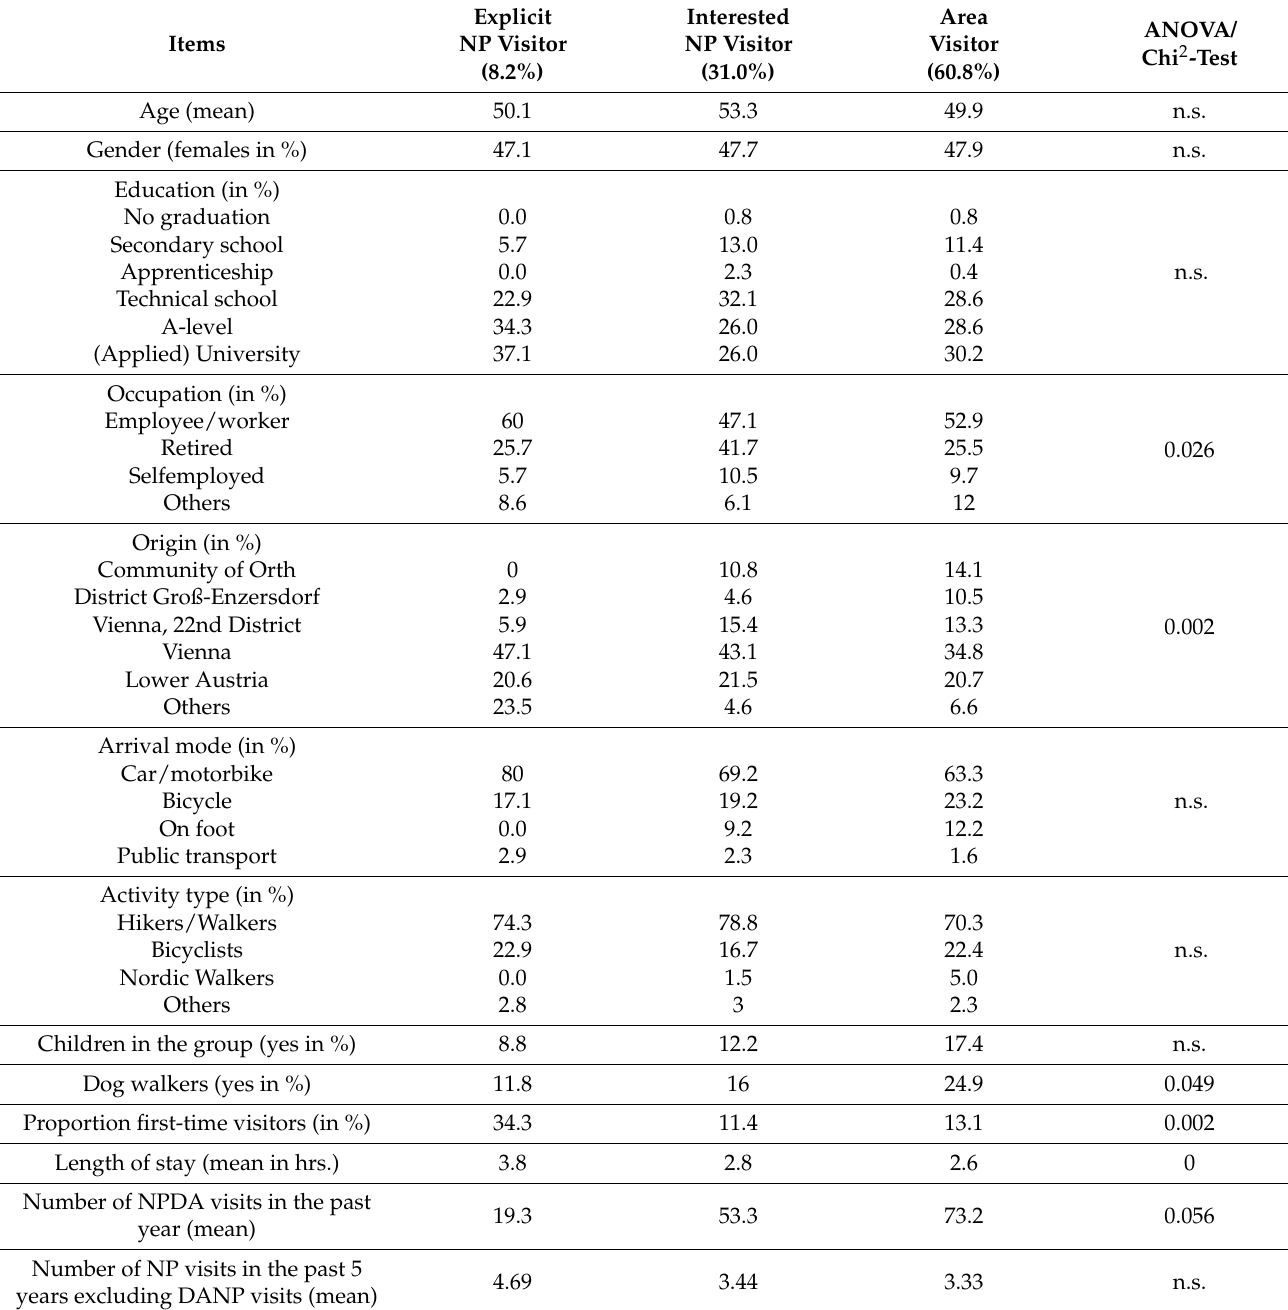
Table 2. Profile of visitor segments with regard to national park affinity (n =